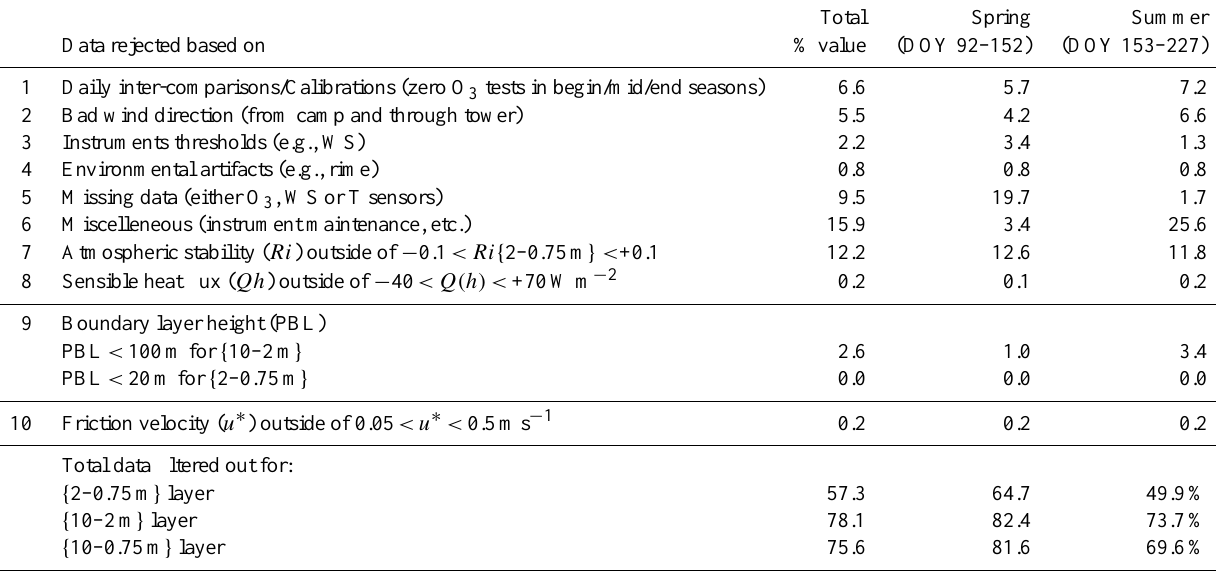
Table 1. Percentage of data that were removed by ten successive quality control filters. Each row lists the additional percentage of data that were eliminated from the data remaining after applying all preceding filters. Spring=DOY 92–152 (1 April–31 May); Summer=DOY 153–227 (1 June–14